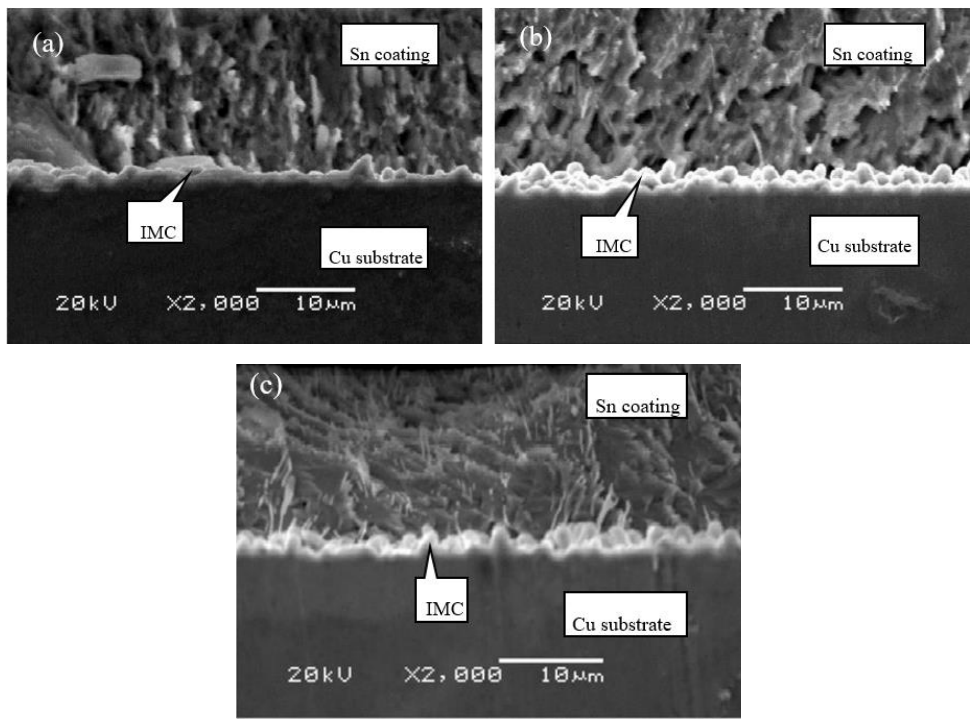
Figure 9. Cross-sectional microstructure of C19210 foils coated at 280 °C with different dipping time: ( a ) 4 s, ( b ) 8 s, and ( c ) 16 s.